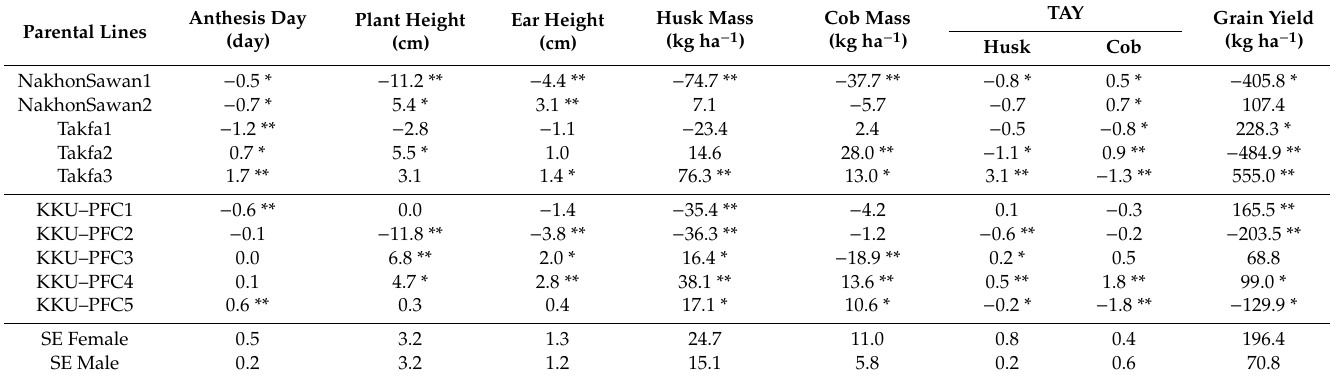
Table 4. General combining ability e ff ects (GCA) for agronomic traits, anthocyanin yield, and grain yield of parents across two locations.